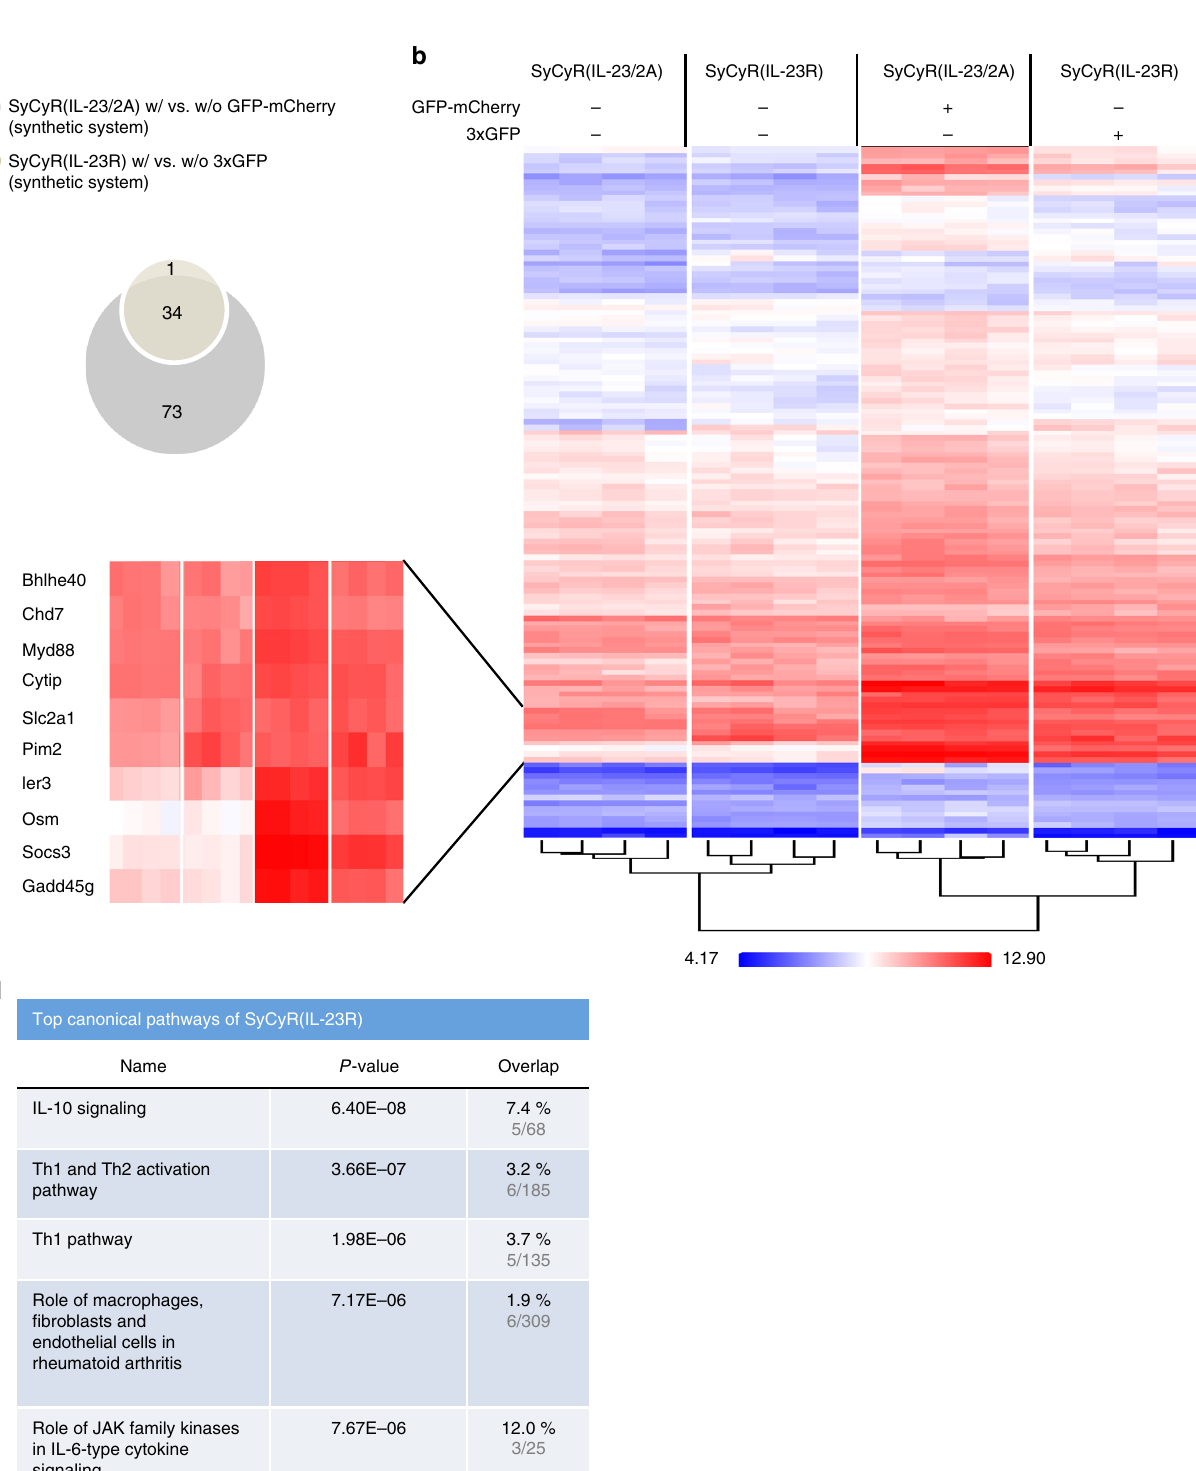
Fig. 6 Microarray analysis of Ba/F3-SyCyR(IL-23R) cells. a Venn-diagram of at least 1.5-fold ( p -value ≤ 0.01) up- or downregulated mRNAs of Ba/F3- SyCyR(IL-23R) cells stimulated with 100 ng/ml 3xGFP (yellow) and Ba/F3-SyCyR(IL-23/2A) cells stimulated with 100 ng/ml GFP-mCherry (light gray) for 60 min. Microarray analysis was performed using samples of four independent biological replicates. b Heat map comparing mRNA levels of Ba/F3-SyCyR (IL-23R) and Ba/F3-SyCyR(IL-23/2A) stimulated and unstimulated as described in a . c Higher magni fi cation of selected mRNAs from b . d Ingenuity pathway analysis (IPA) revealed the top fi ve canonical pathways of Ba/F3-SyCyR(IL-23/2A) vs.